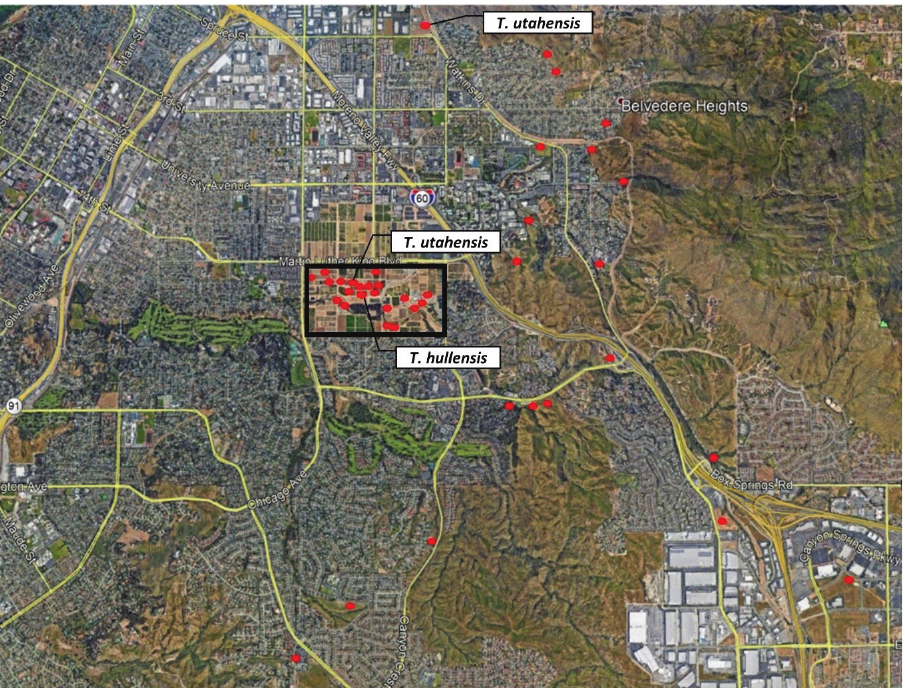
Figure 1. Survey locations are displayed in red dots. The black rectangle shows the Agricultural Opera- tions of the University of California, Riverside, where most of our surveys were conducted. Five Trissolcus hullensis were recovered from an alfalfa field (33.96508°N, 117.34084°W), one Trissolcus utahensis was recovered from a squash field with mustard weeds (33.96611°N, 117.34230°W), and eleven T. utahensis were recovered from roadside mustard weeds (33.99105°N,